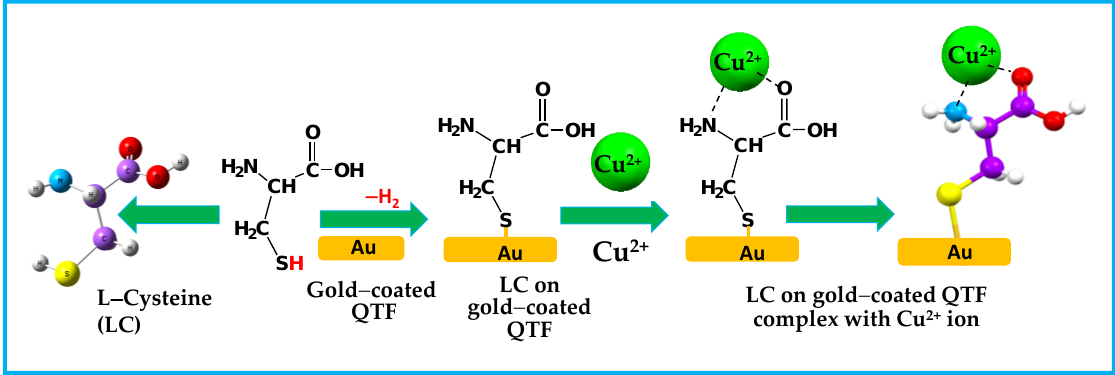
Figure 2. Proposed binding mode of the LC on Au-coated − QTF complex with Cu 2+ ions (counterion not shown). Color code: carbon = purple, nitrogen = blue; oxygen = red; copper = green; sulfur = yellow; gold = orange and hydrogen atoms = white.